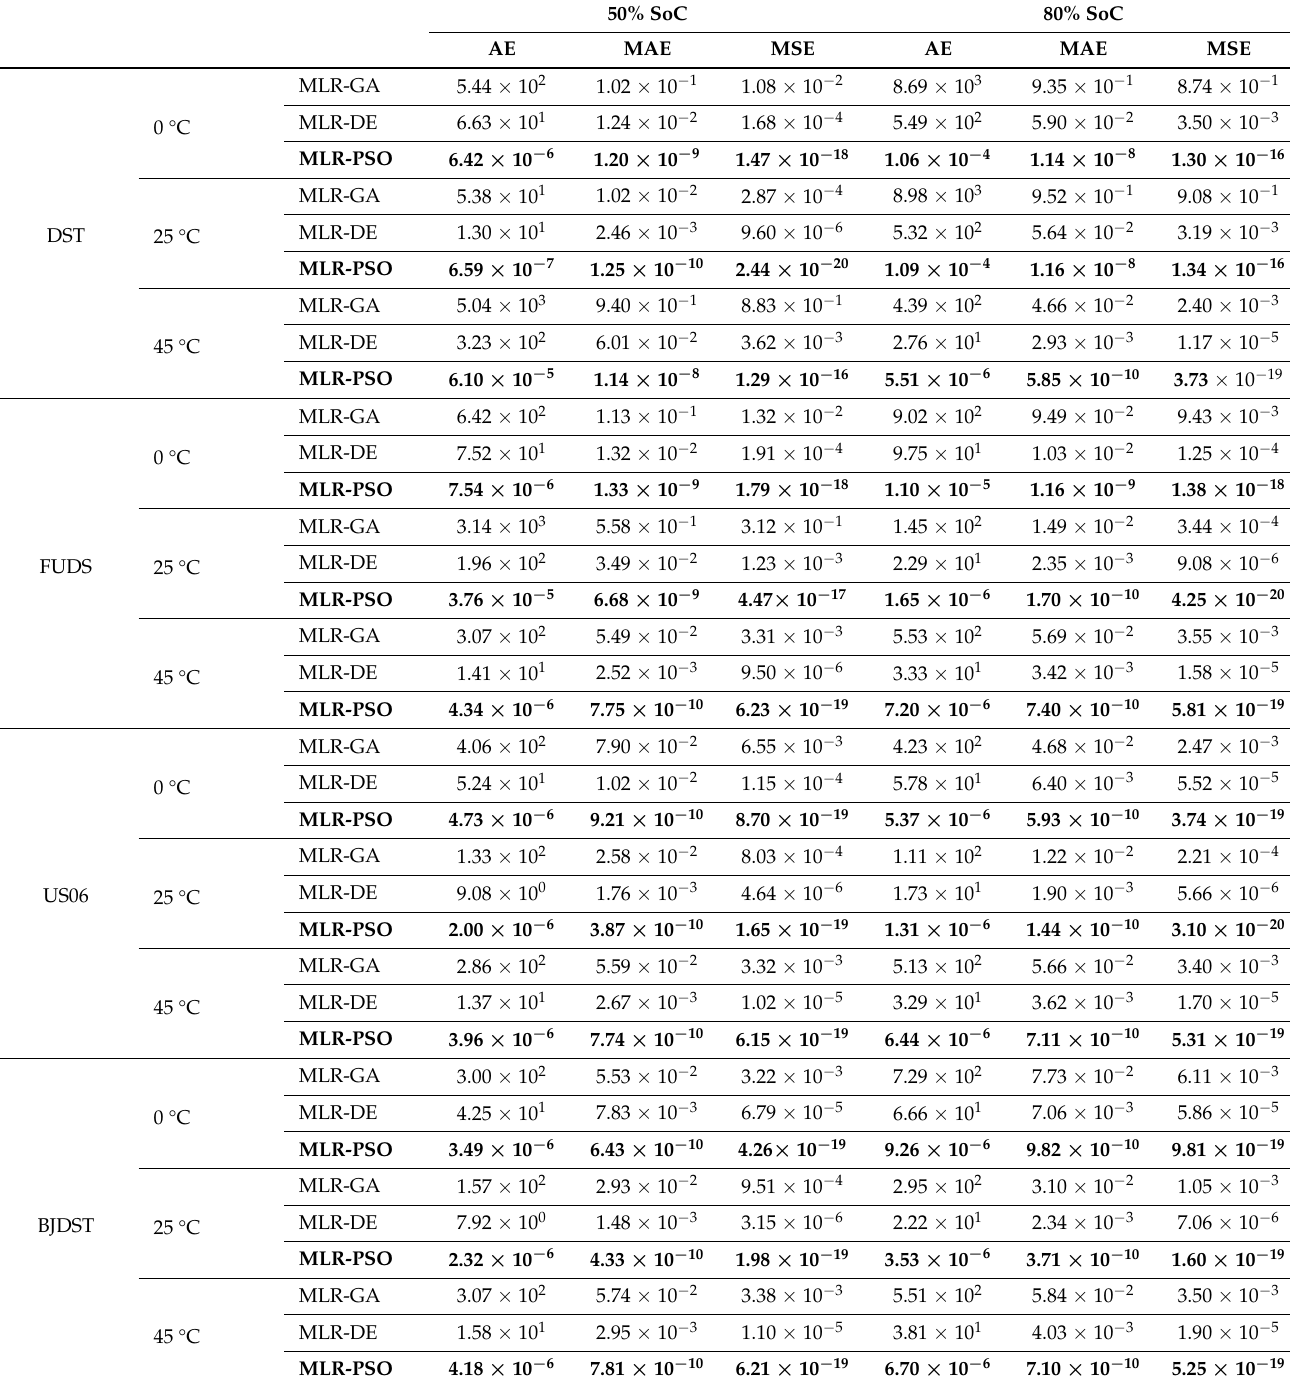
Table 3. Test results for all profiles at different SoC and temperatures, to MLR